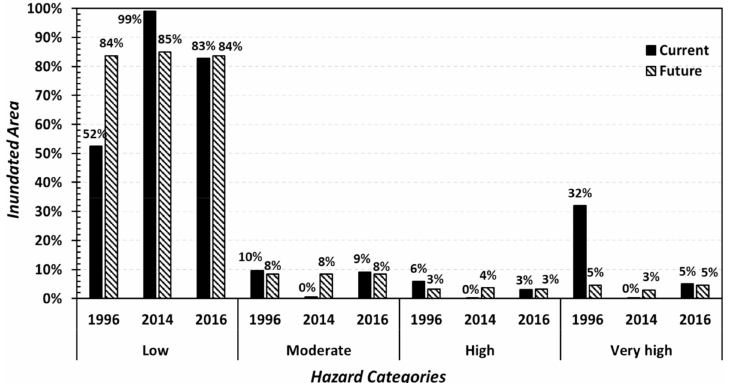
Figure 10. Flood inundation percentages for the current and future (2027) situations for the events in 1996, 2014, and